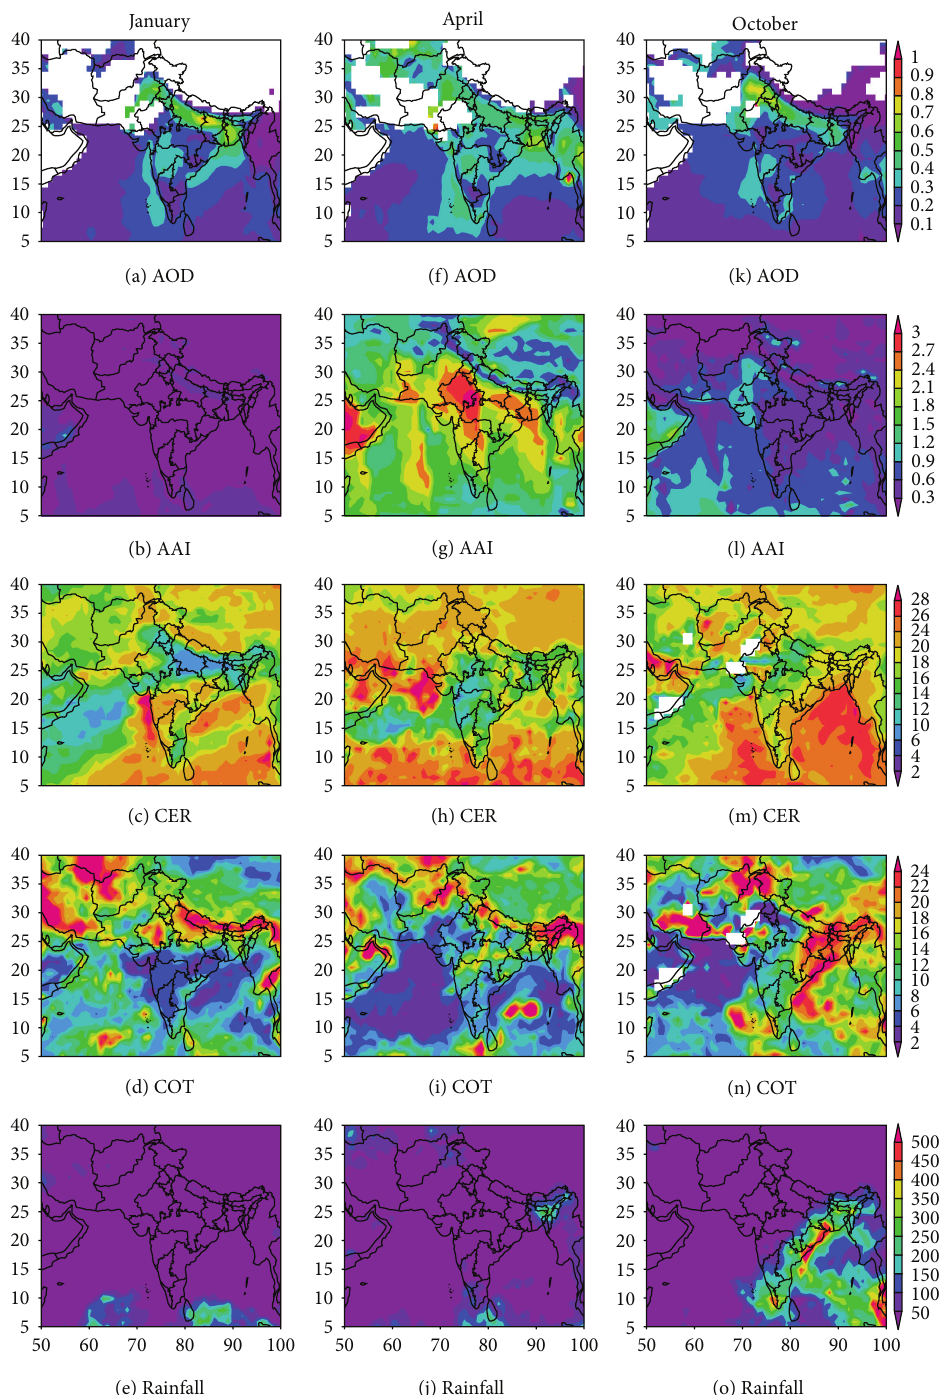
Figure 4: ((a), (f), and (k)) Aerosol optical depth (AOD), ((b), (g), and (l)) absorbing aerosol index (AAI), ((c), (h), and (m)) cloud effective radius (CER, 𝜇 m), ((d), (i), and (n)) cloud optical thickness (COT), and ((e), (j), and (o)) rainfall (mm) in January, April, and October of 2003, respectively, for